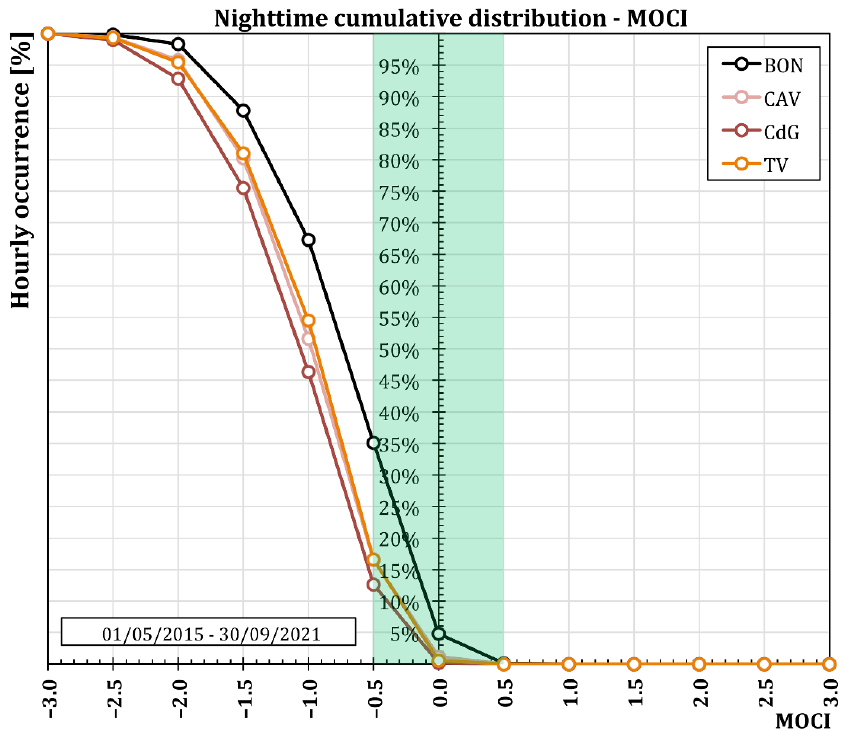
Figure 7. Cumulative distribution of average nocturnal (from 20:00 to 05:00 LT) MOCI index for the four ARPA stations.